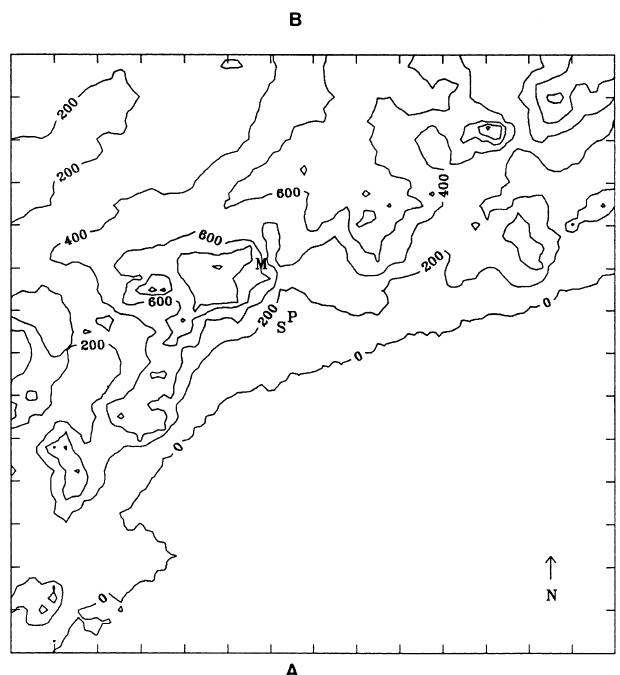
Fig. 1. Map of the analyzed region. Spacing between elevation contours is 200 m. P indicates the main source of pollutant, M the surface meteorological and air quality measuring station, and S corresponds to the sodar location. Divisions markers are every 10